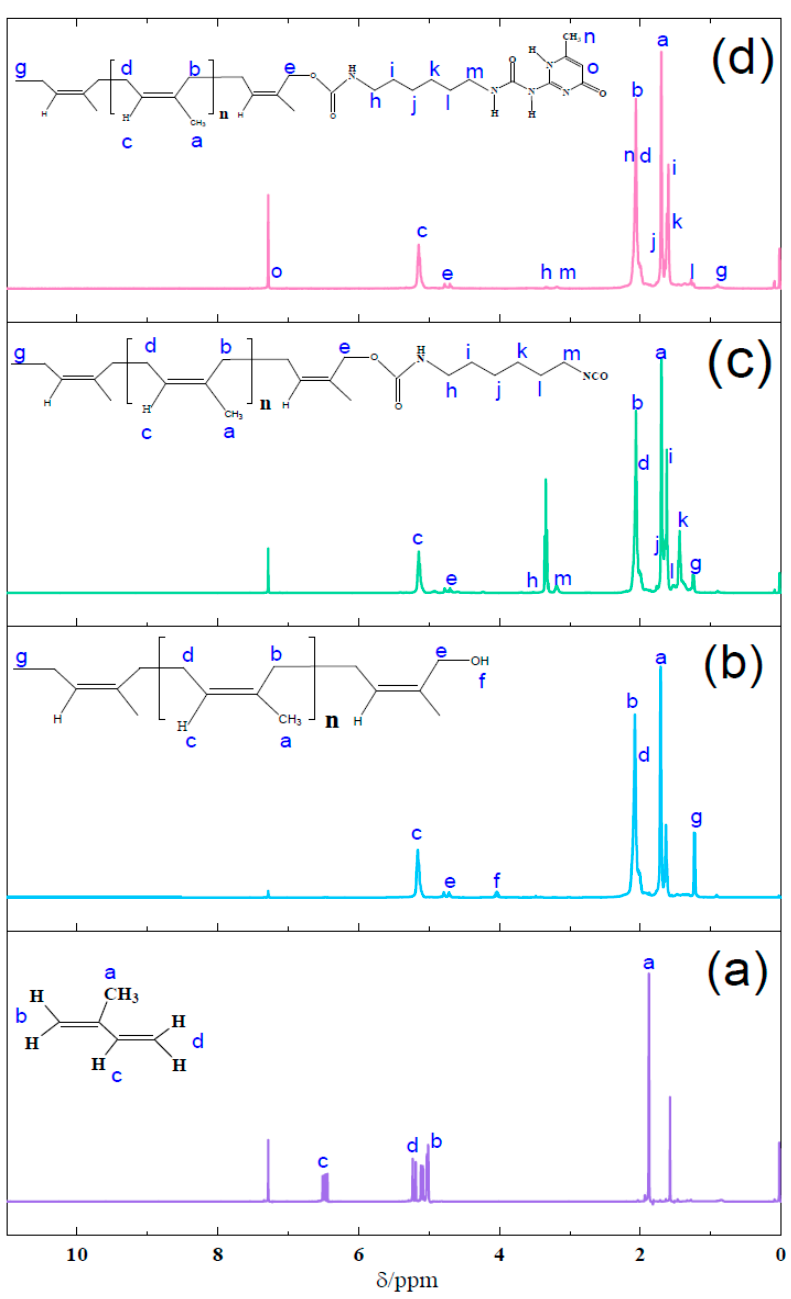
Figure 5. 1 H-NMR spectra of ( a ) isoprene, ( b ) PI-OH, ( c ) PI-NCO, and ( d ) PI-UPy.